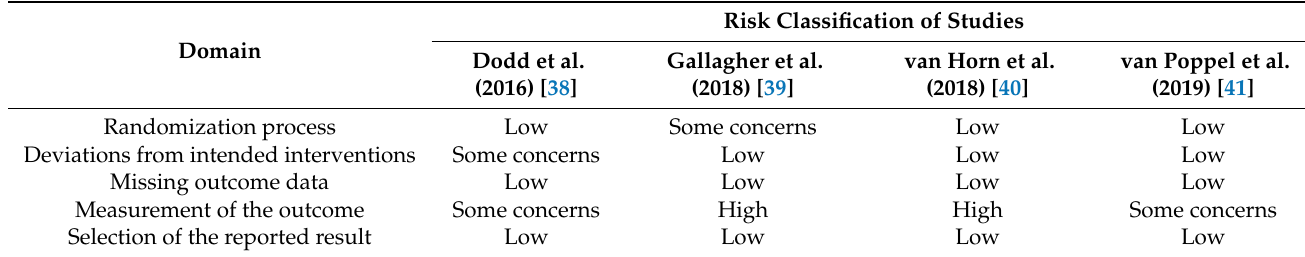
Table 2. Sources of bias and risk classification in each included